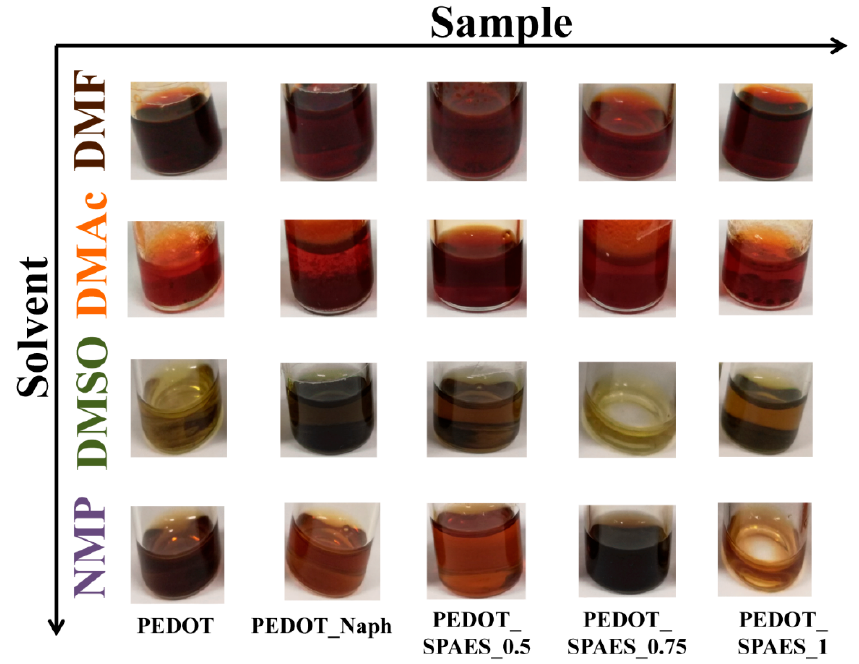
Figure 2. Summary of the polymeric solutions synthesized and their appearance.